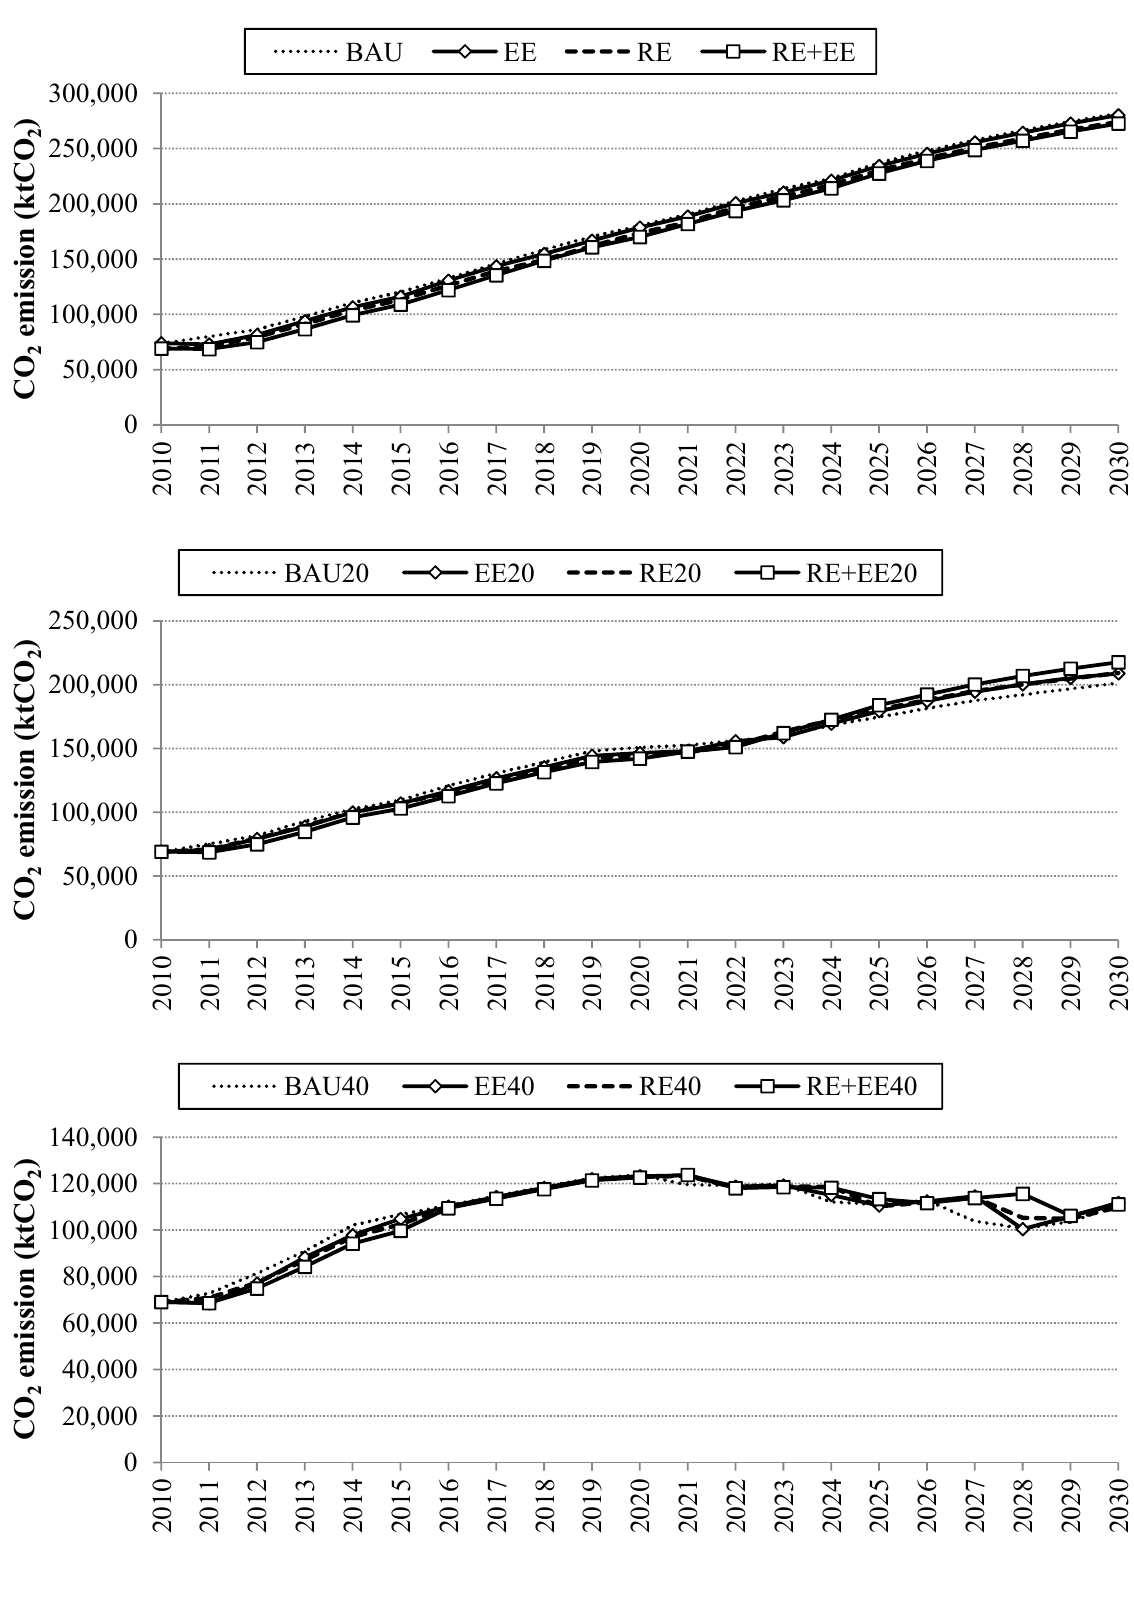
emissions in the CO 2